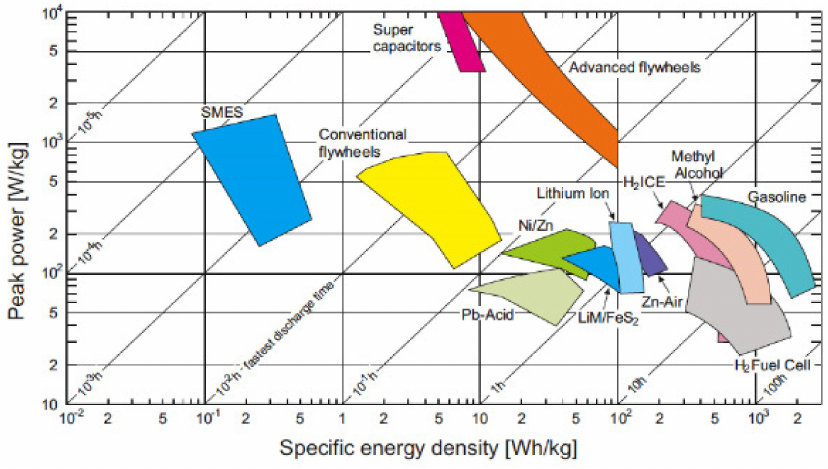
Figure 1. Ragone chart